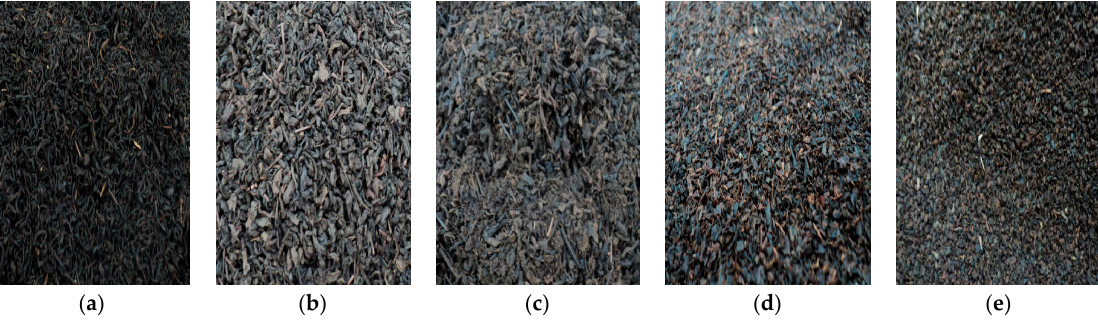
Figure 6. Roll form ( a ) green tea, ( b ) Pu Erh tea, and ( c ) Oolong tea leaves. Crush form ( d ) Sabah tea and ( e ) Boh tea.